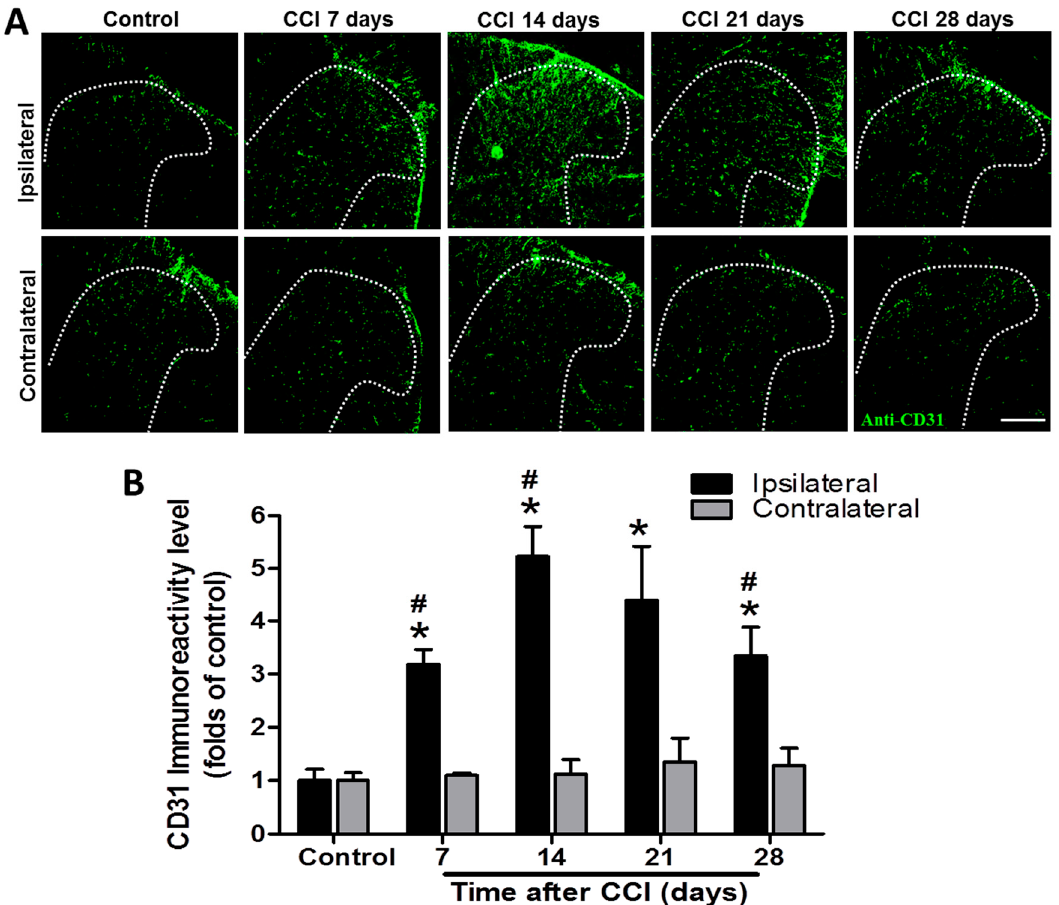
Figure 2. Representative cluster of differentiation 31 (CD31) immunostaining in the rat lumbar spinal cord dorsal horn (SCDH) over a 28 − day period of chronic constriction injury (CCI) − induced neuropathic pain. ( A ) Representative CD31 immunofluorescence (green) in the ipsilateral SCDH of control rats and CCI rats at post − operative day (POD) 7, 14, 21, and 28 (20 − µm sections; magnification: 100×; scale bars: 300 µm). ( B ) Quantification of immunofluorescence reactivity in the contralateral and ipsilateral SCDHs (4 sections per rat, 3 rats per group and each time point); values are expressed as means ± standard error of means (SEMs). * p < 0.05 relative to the same side of controls; # p < 0.05 relative to the contralateral side of the same group at the same time point, one-way analysis of variance (ANOVA) with post hoc Tukey test.